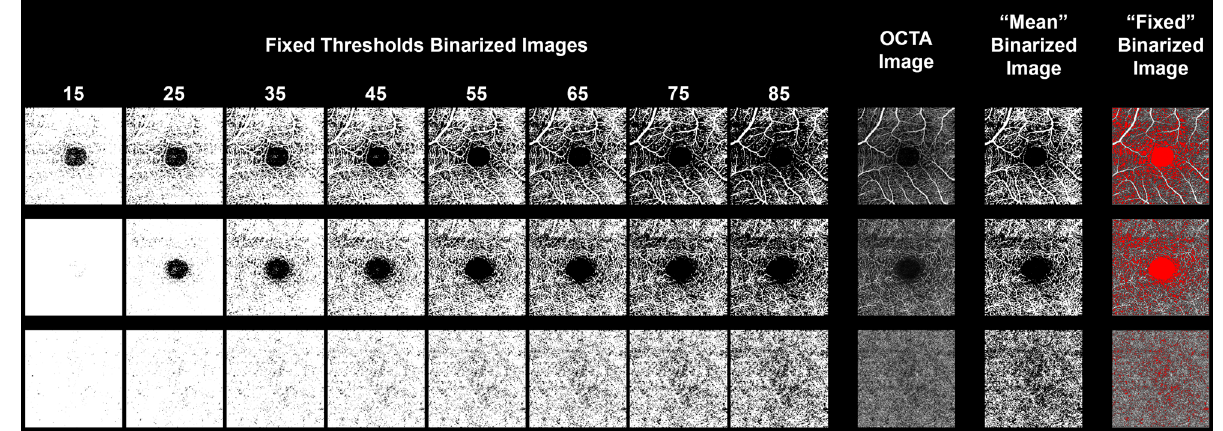
Figure 1. Fixed thresholding tests. SCP, DCP and CC reconstructions are respectively shown in upper, middle and lower lines. Original OCTA reconstructions and “Mean” threshold binarized images are shown as well. The fixed values chosen are 65 for SCP and DCP, and 85 for CC, resulting in the most reliable selection of capillaries, if compared to the original OCTA reconstructions, with respect to the empty background (highlighted in